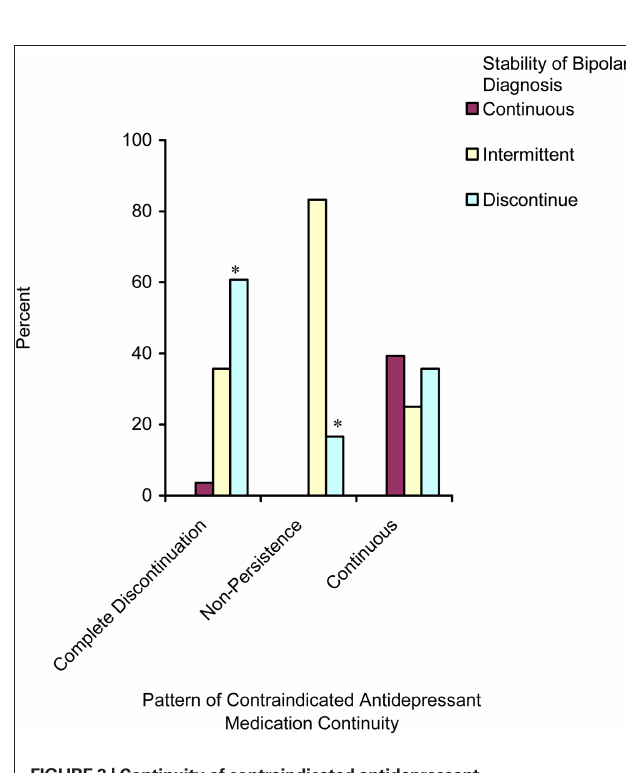
FIgURe 3 | Continuity of contraindicated antidepressant prescriptions (without a mood stabilizer or antipsychotic) by stability of bipolar diagnosis only including those who ever initiate ( n = 142, * p <